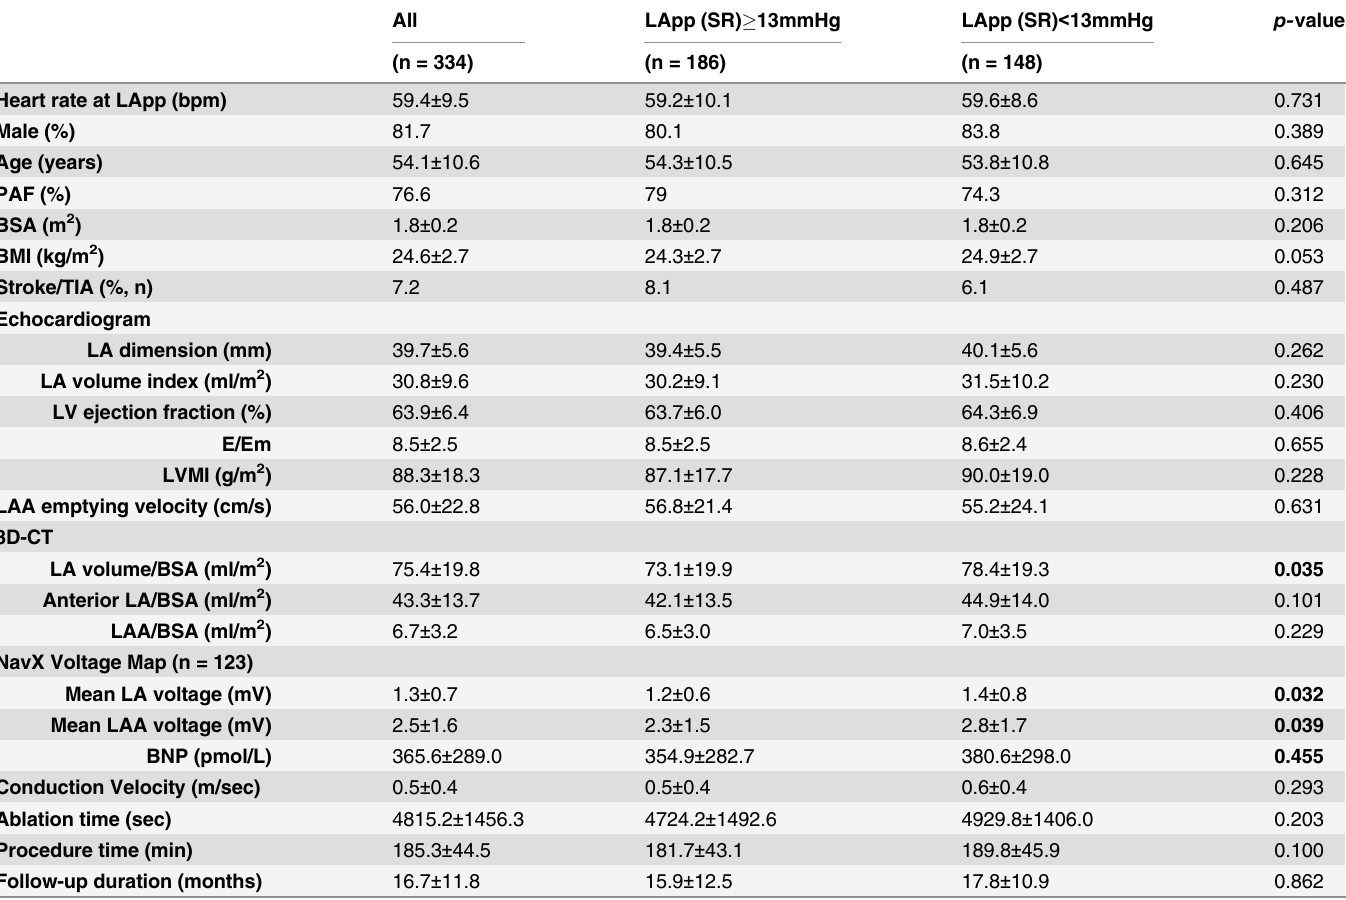
Table 2. Baseline characteristics of patients according to the LA